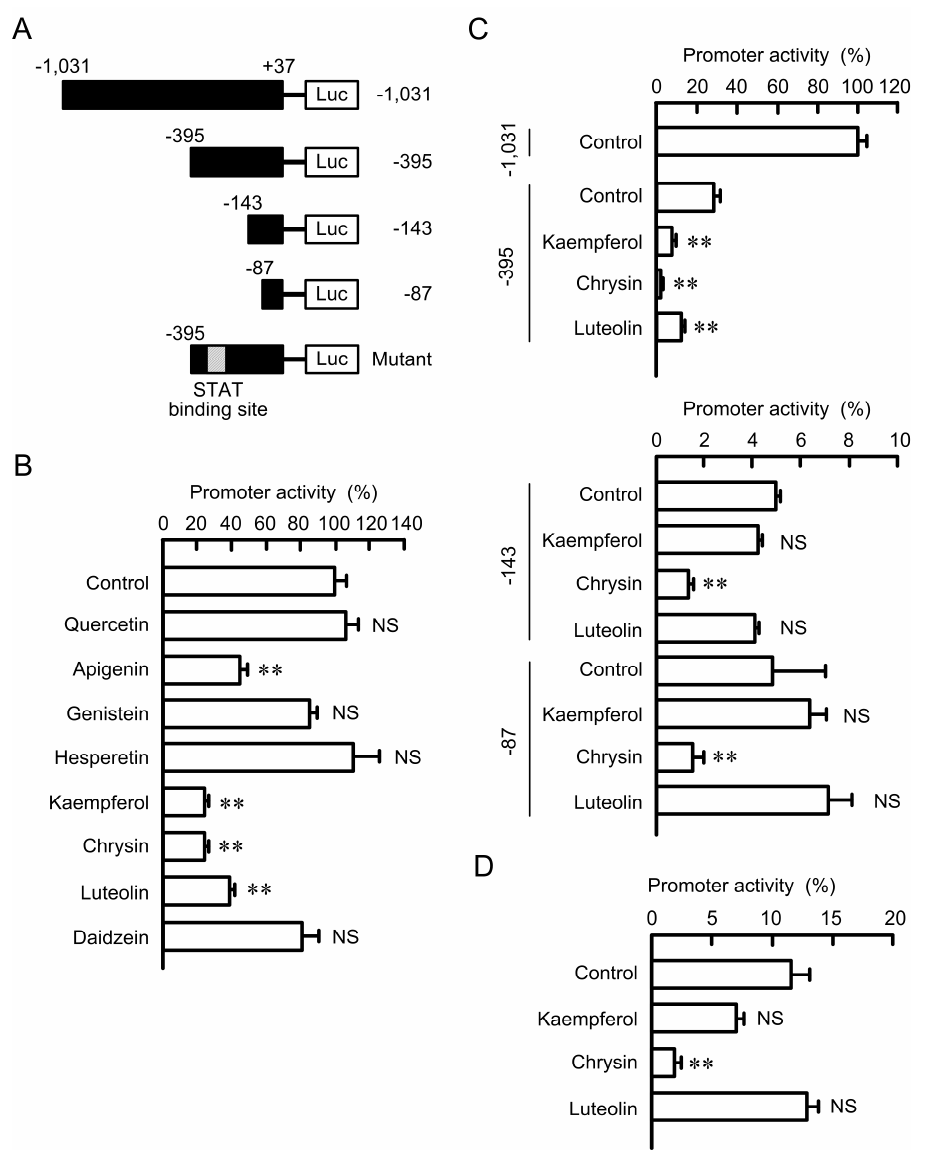
Figure 7. Effects of flavonoids on the promoter activity of human claudin-2. ( A ) Schematic drawing of human claudin-2 luciferase reporter vector; ( B ) The cells were co-transfected with luciferase − 1031/pGL4.10 and pRL-TK vectors. After 24 h of transfection, the cells were incubated in the absence and presence of 50 μ M flavonoids for 24 h. The promoter activity of claudin-2 was represented relative to the values in control; ( C ) The constructs of 5 ′ -deletion series including − 395, − 143, and − 87/pGL4 vector were co-transfected with the pRL-TK vector; ( D ) The construct of mutant of STAT-binding site was co-transfected with the pRL-TK vector. The relative promoter activity was represented relative to the values of control of − 1031/pGL4 vector. n = 3–4. ** p < 0.01 significantly different from vehicle. NS, not significantly different.